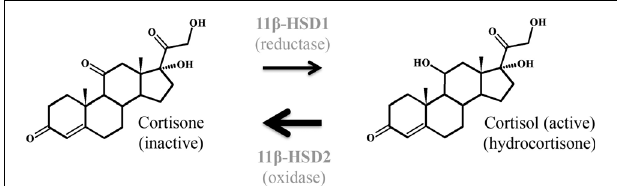
FIGURE 7 | Interconversion of cortisol and the inactive metabolite cortisone by 11 β -hydroxysteroid dehydrogenases type 1 and 2. 11 β -HSD1 exerts mainly reductase activity in vivo , while 11 β -HSD2 metabolizes the conversion of cortisol to cortisone. In human placenta, conversion from cortisol to cortisone predominates at all gestational ages, but increasing conversion of cortisone to cortisol in homogenized human placental tissue toward term indicates a predominant reductase activity of 11 β